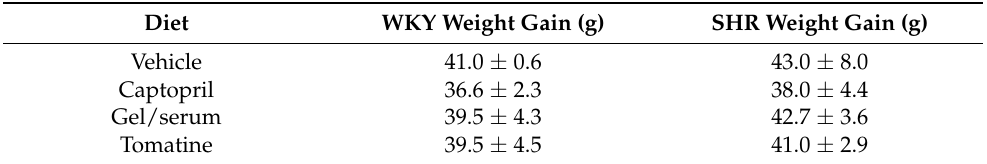
Table 1. Effects of different treatments on body weight (BW) in spontaneously hypertensive rats (SHRs) and Wistar Kyoto (WKY) rats. Diet WKY Weight Gain (g) SHR Weight Gain